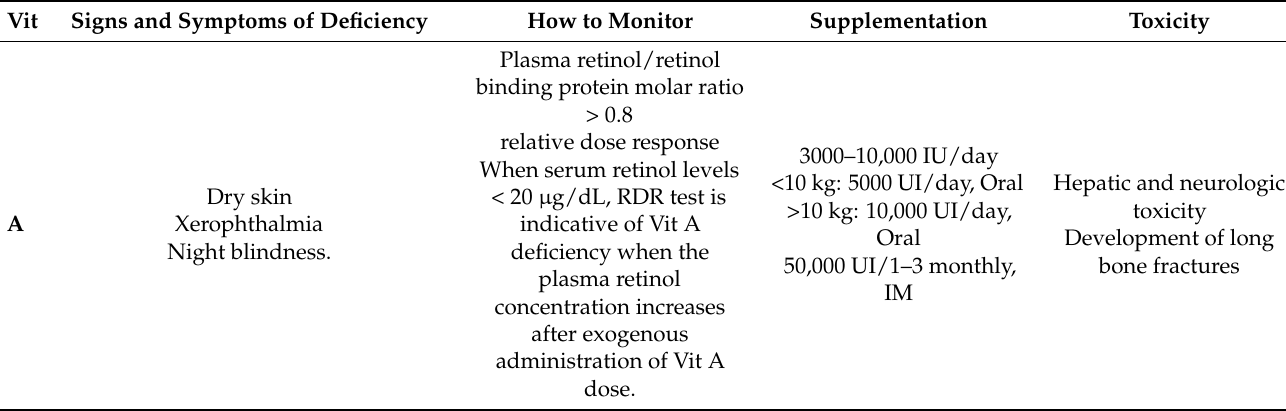
Table 2. Synopsis of fat-soluble vitamin deficiencies and toxicities. Signs and Symptoms of Deficiency How to Monitor